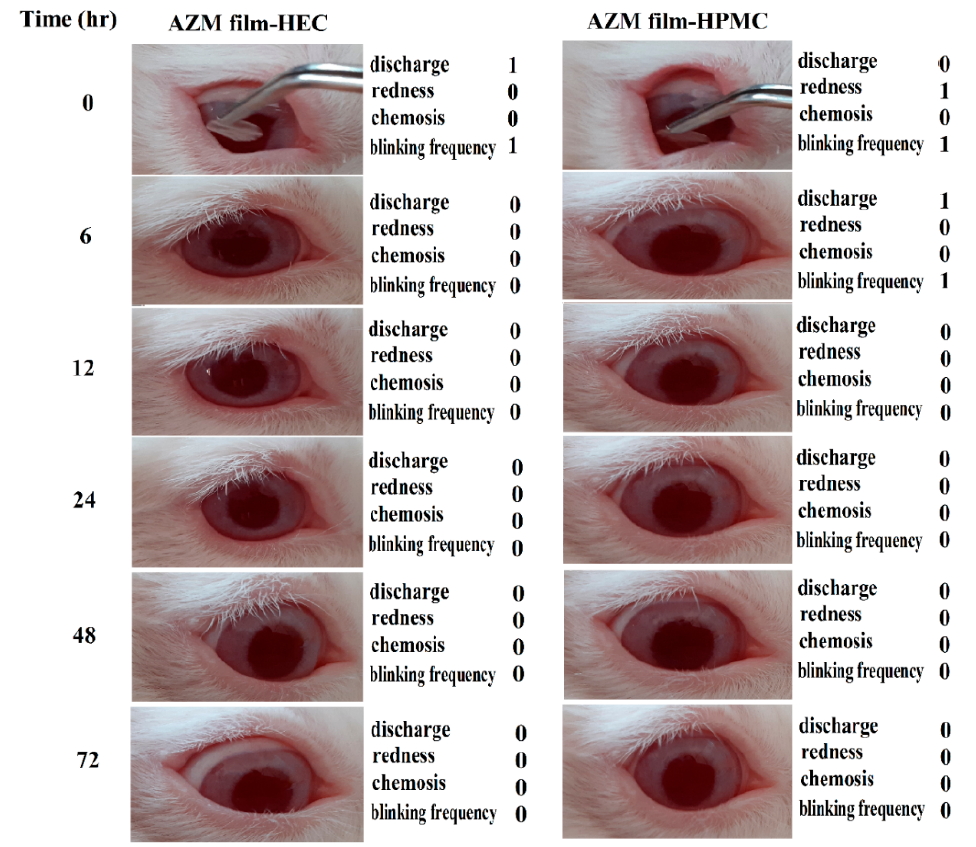
Figure 11. The appearance of rabbit eyes treated with a film containing azithromycin-loaded Eudragit ® L100 nanoparticles for ocular delivery acquired at 0 to 72 h.